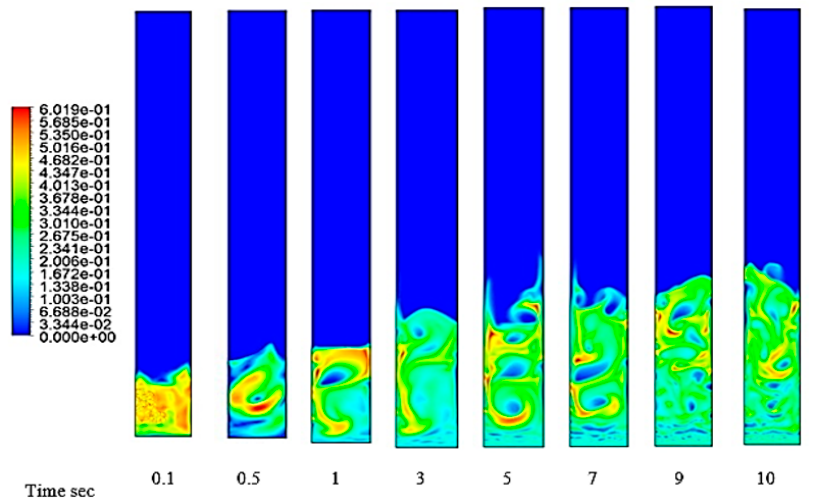
Figure 8. The volume fraction of particles diameter of 3 mm with different times.